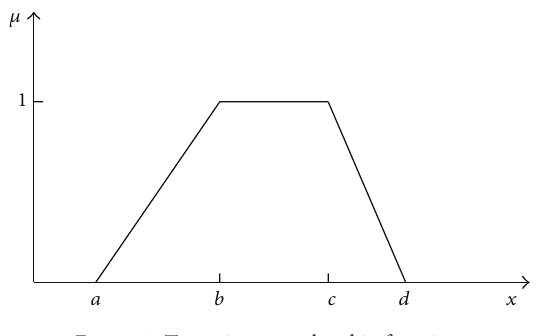
Figure 1: Trapezium membership